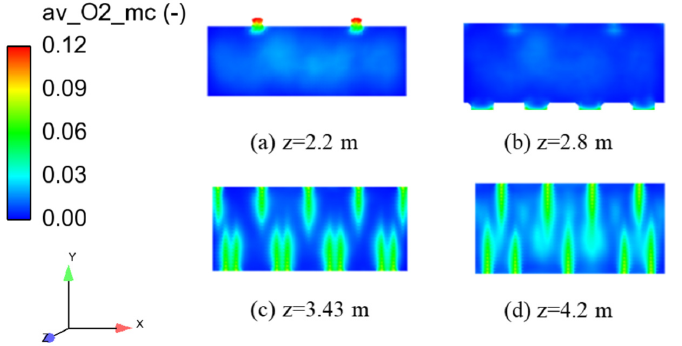
Figure 12. Distributions of oxygen concentration in cross-sections of dense phase zone in Case 2 (( a )—returning port; ( b )—fuel-feeding port; ( c )—lower secondary air; ( d )—upper secondary air).